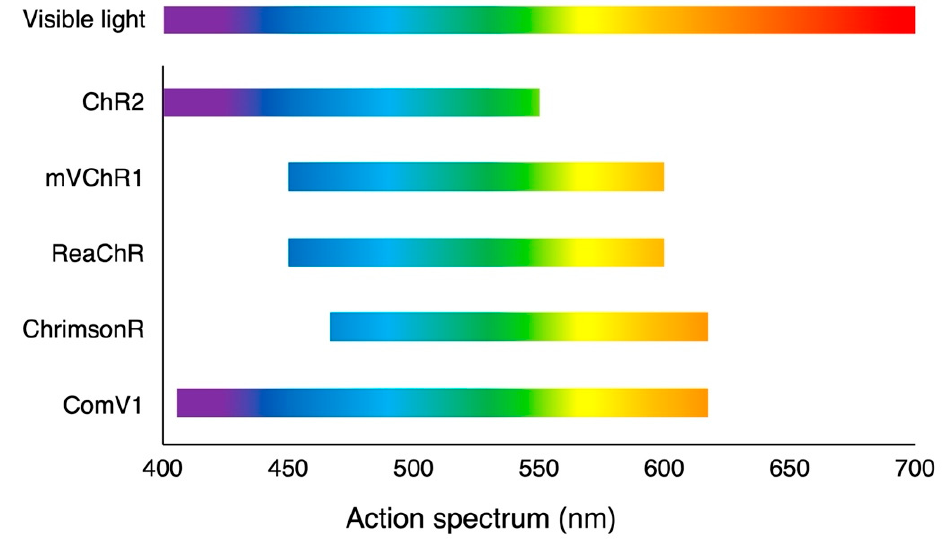
Figure 3. Action spectra of depolarizing opsins. Engineered variants have red-shifted spectra compared with ChR2.